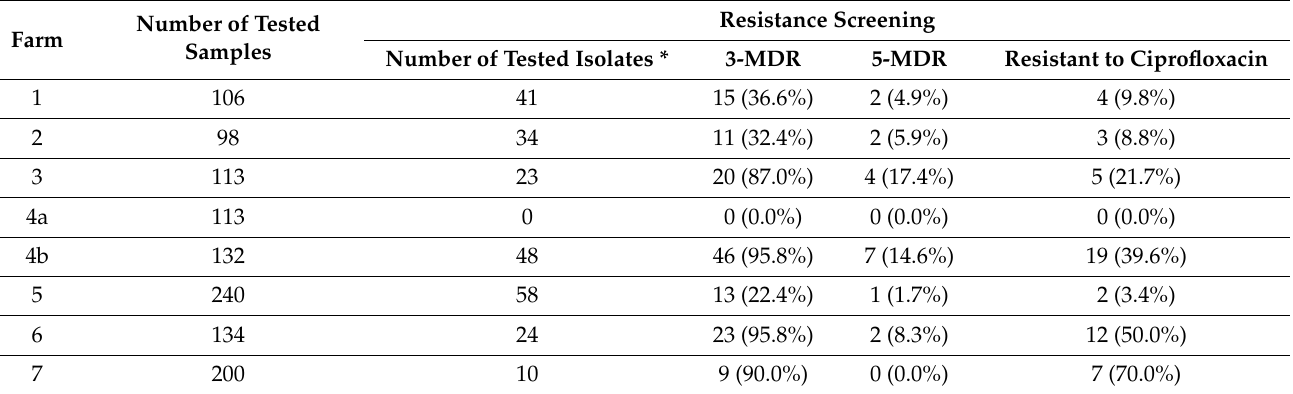
Table 2. Bacteriologically positive samples in fattening pigs and results of resistance screening. 3-MDR = isolates resistant to penicillin and cephalosporins and at least one other class of antibiotics; 5-MDR = isolates resistant to penicillin and cephalosporins and at least three other classes of